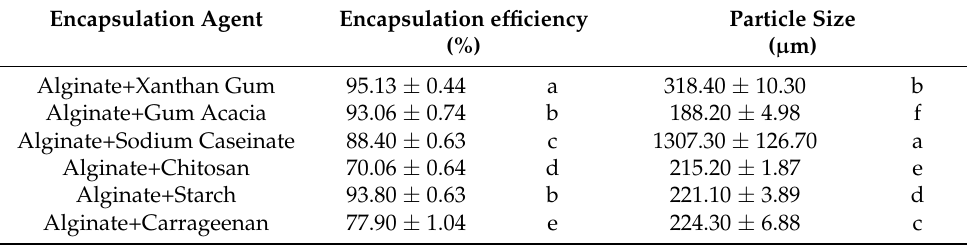
Table 1. Encapsulation efficiencies and particle sizes of different L. rhamnosus microcapsules.